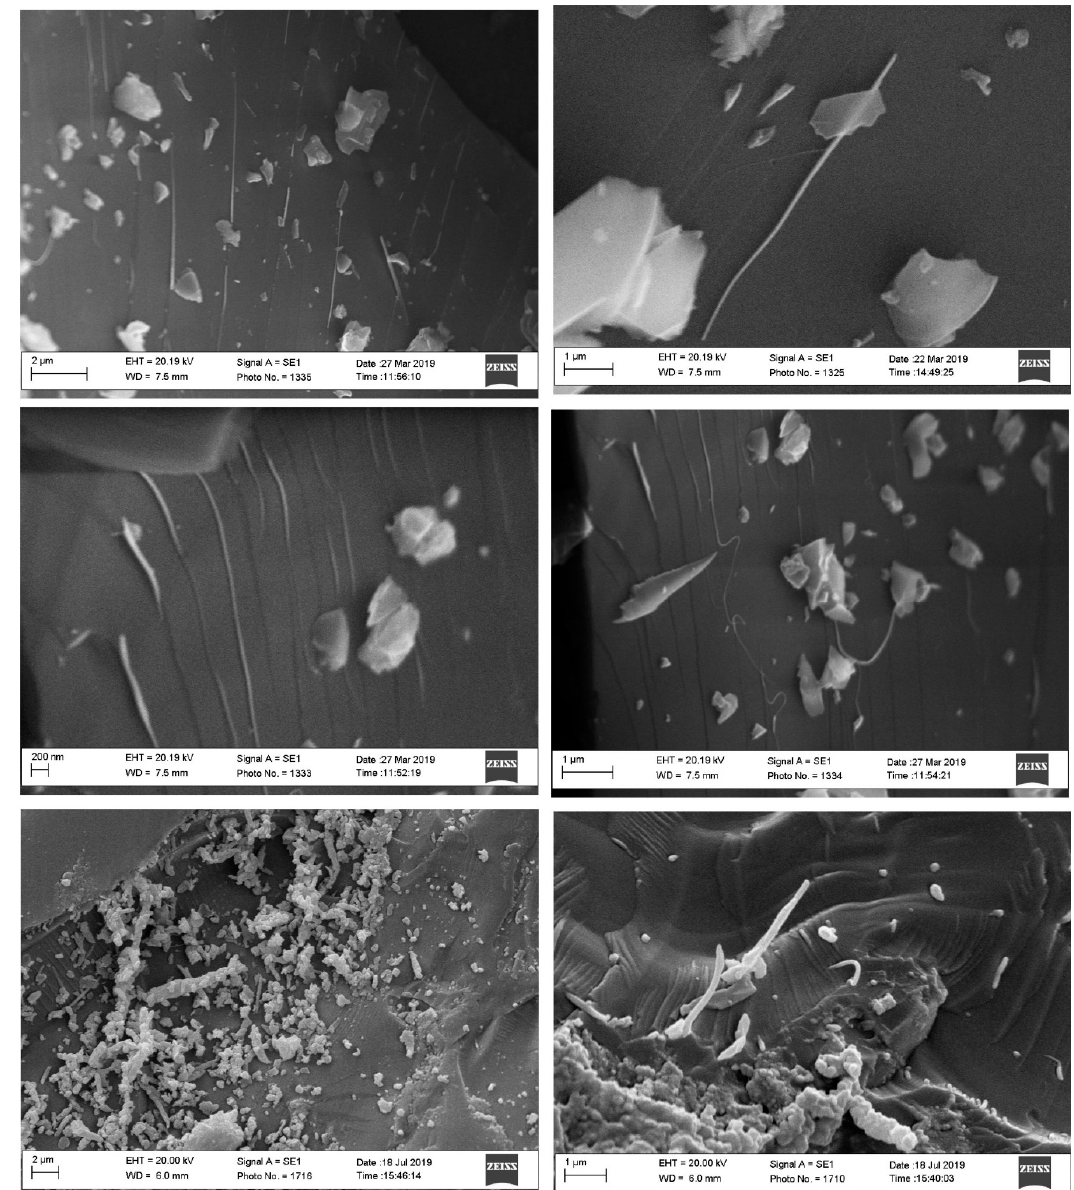
Figure 11. Filamentous forms of silica that are an integral part of fractures of the type shown in Figure